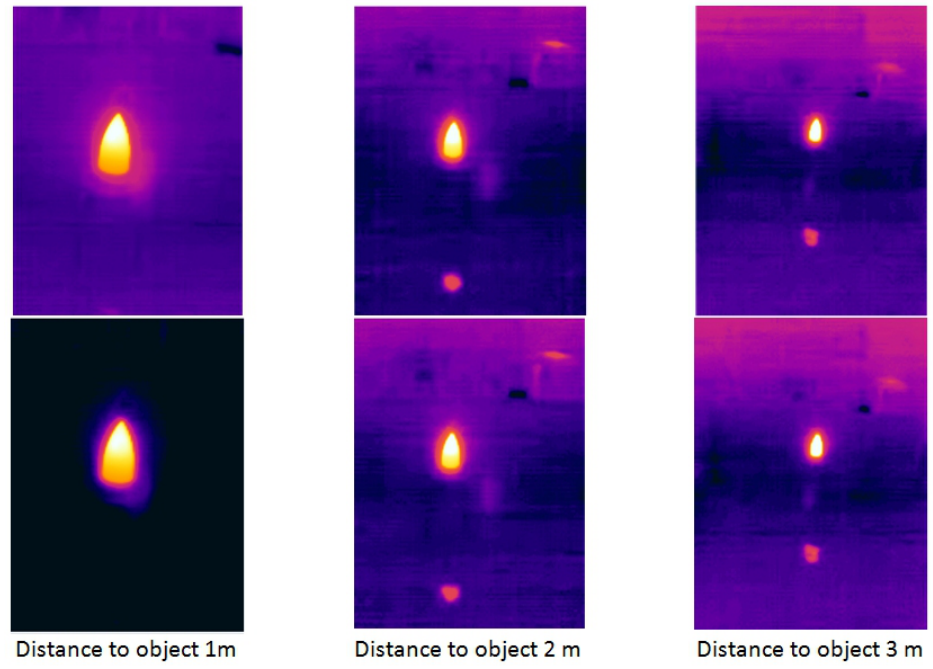
Figure 2. Examples of thermograms used in study— static hot object—training